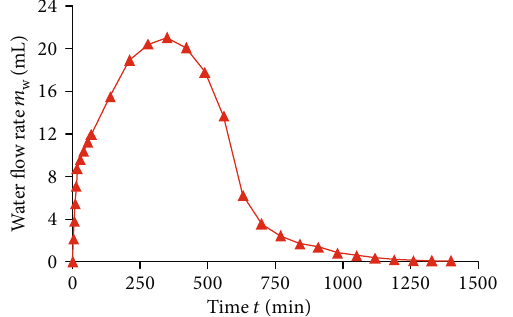
Figure 5: The variation of water fl ow rate with time in 3-D marine sediments for the whole water production